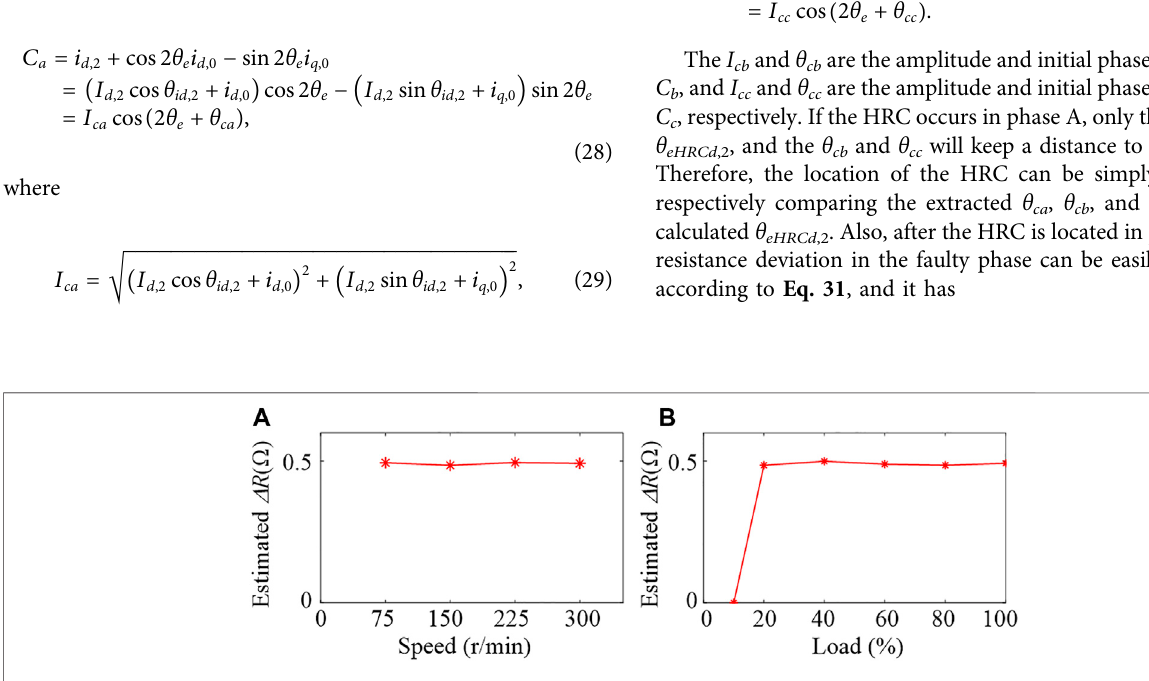
FIGURE 13 | Estimated Δ R . (A) Rated load at a different speed; (B) different loads at 300 r/min.